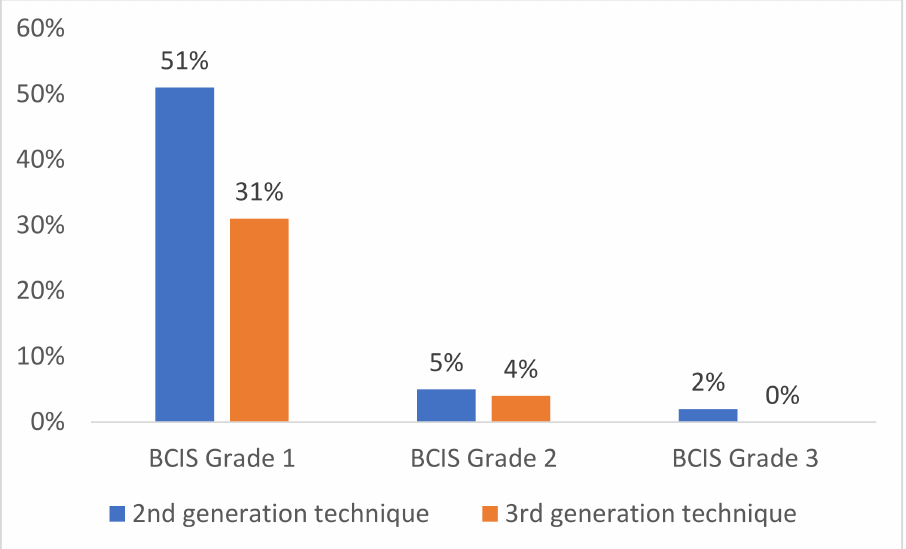
Figure 2. Severity of BCIS in 2nd and 3rd generation technique.